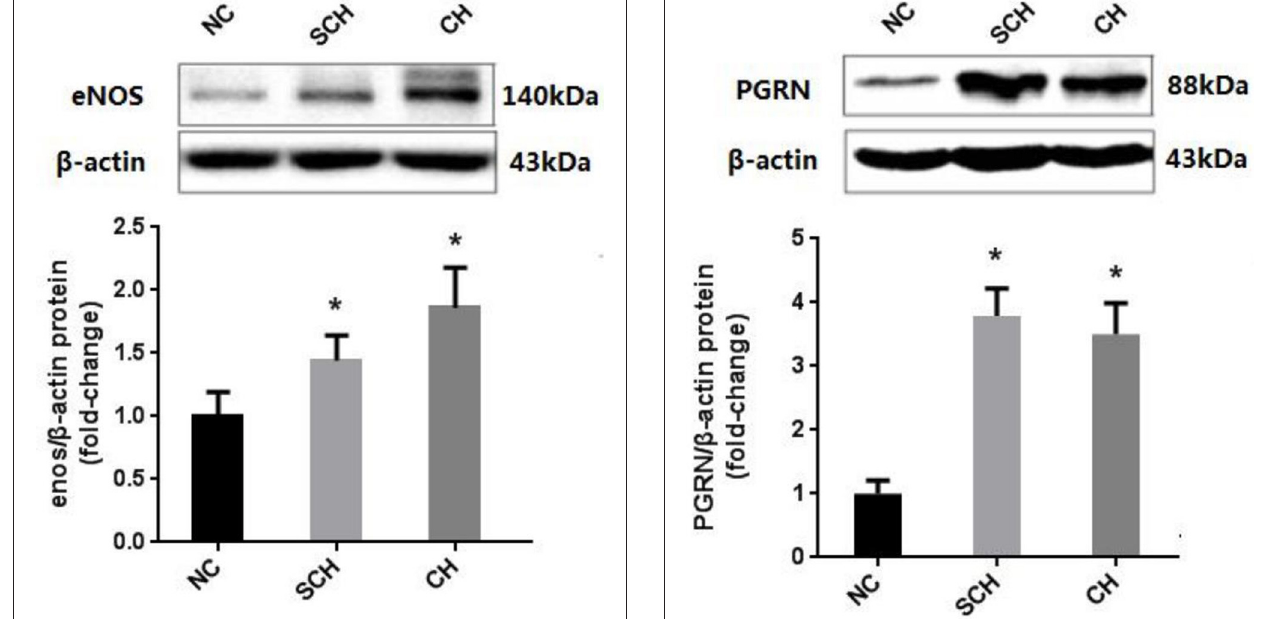
primer pairs were as follows: eNOS , 5 ′ -CTC GTC CCT GTG GAA